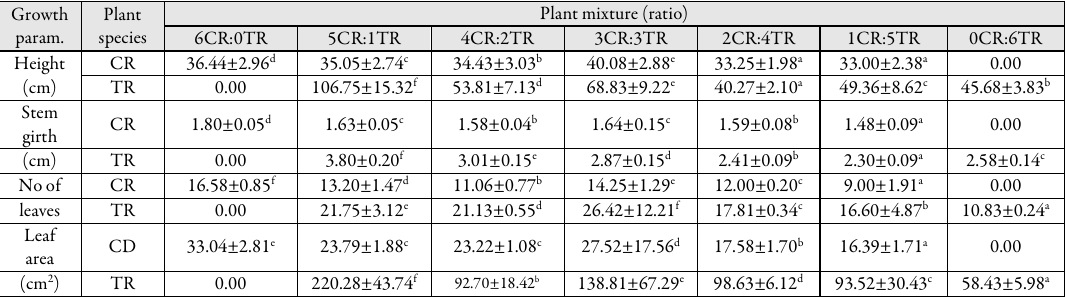
Table 3. Growth parameters of T. rotundifolia and C. odorata under different levels of interspecific competition Growth param.